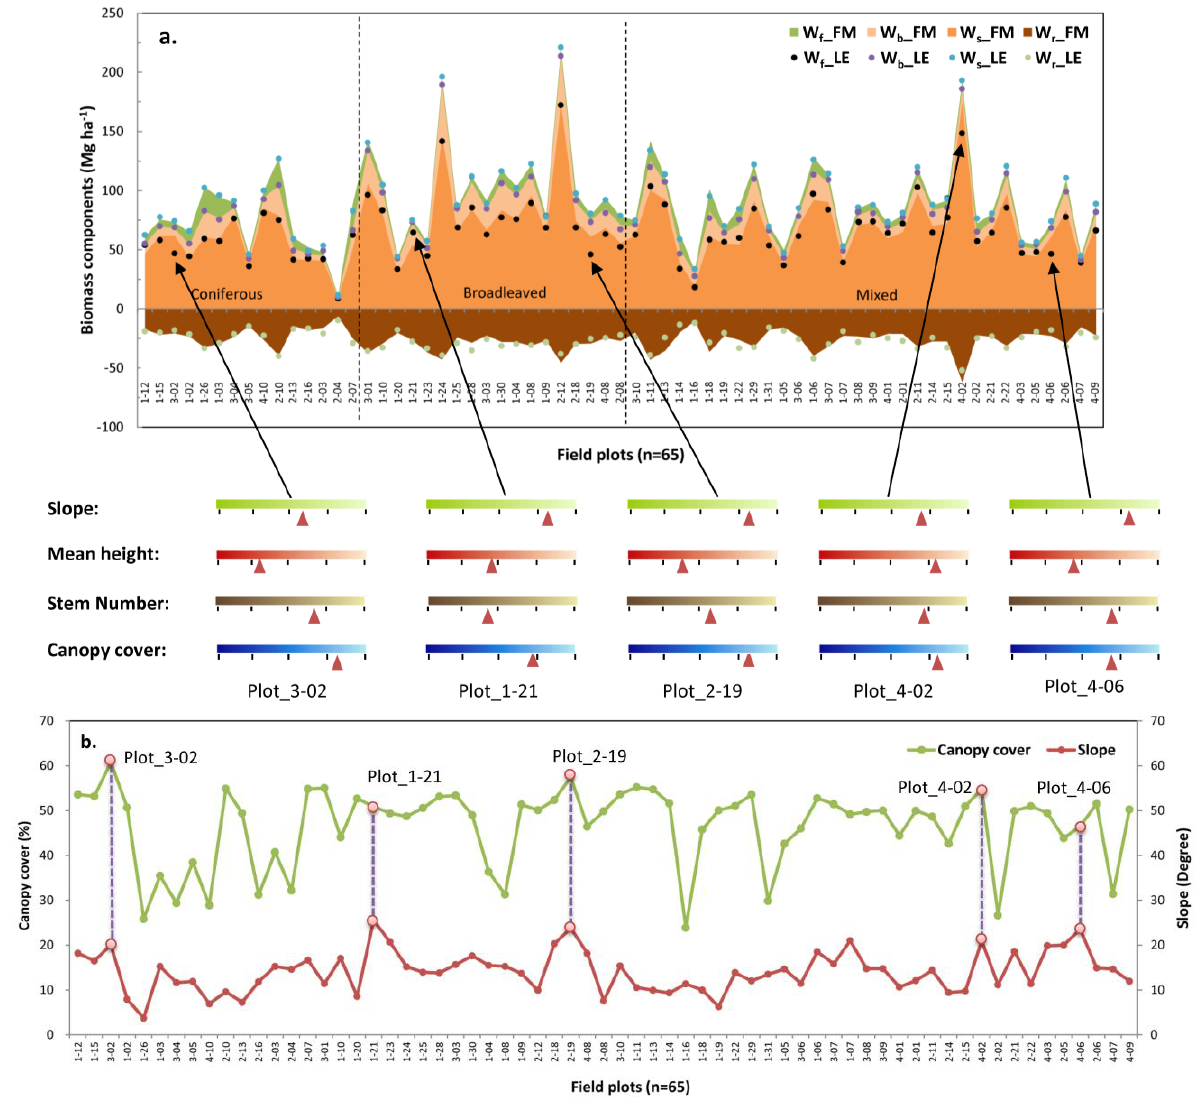
Figure 9. Relationship between the amount of field-measured and LiDAR-estimated biomass components across all field plots ( n = 65) (abscissa: all of the 65 field plots; ordinate: the amount of biomass components): ( a ) the field-measured biomass components are displayed as area. The biomass components estimated by the combo model are displayed as dots; five plots with the largest bias in trunk biomass are highlighted and analyzed against four topographic and vegetation factors; ( b ) slope (degree) and canopy cover (%) of all plots with the five outlier plots highlighted.